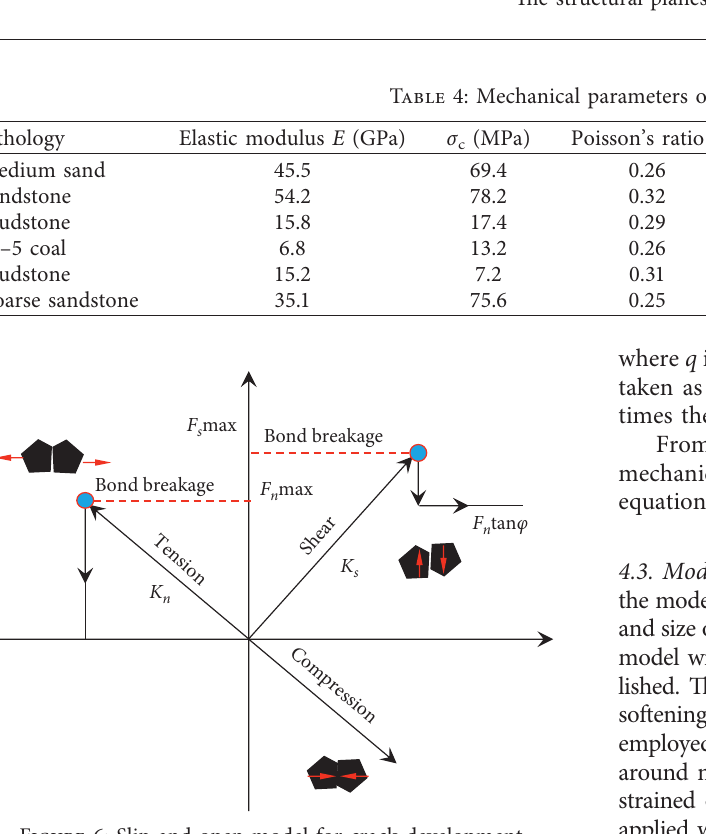
Figure 6: Slip and open model for crack